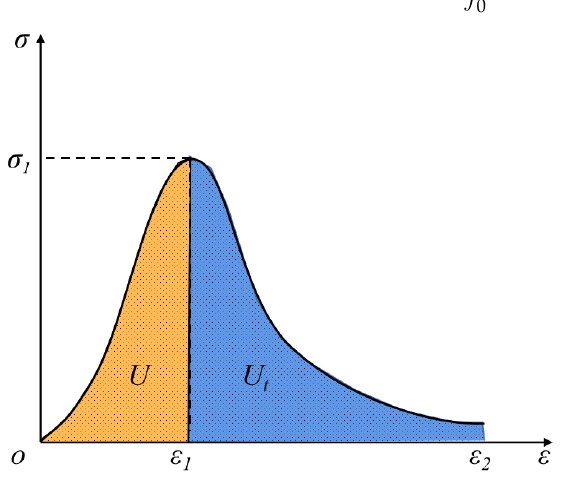
Figure 6. Sample stress–strain curve. Energy dissipation